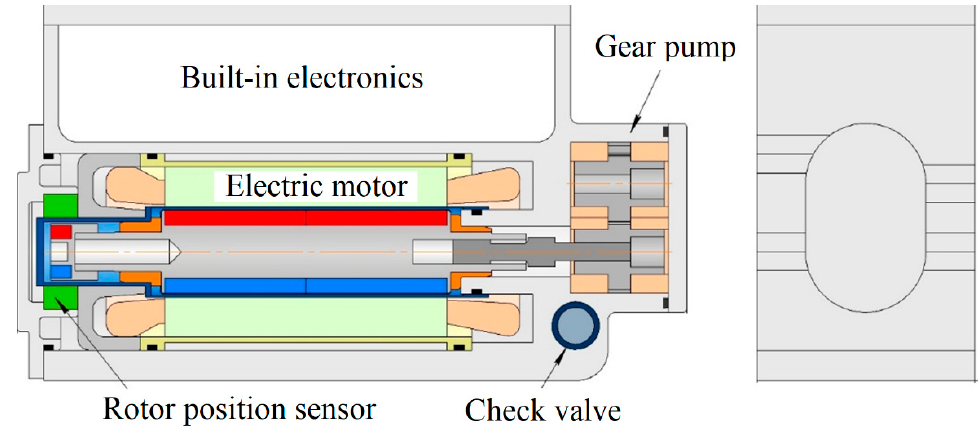
Figure 14. Design of the electric drive pump.